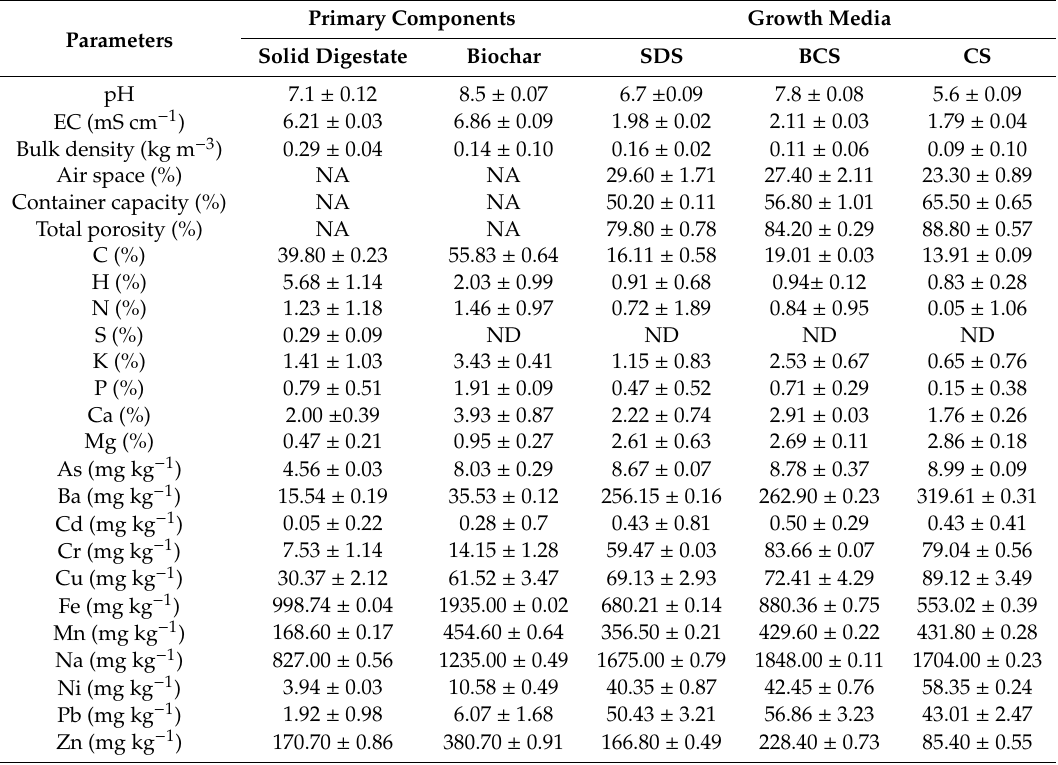
Table 1. Physical–chemical properties of organic material and growth media used in P. graveolens cultivation. All values are means of three replicates ± standard deviation. Solid digestate; biochar; SDS (Solid Digestate Substrate); BCS (Biochar Substrate); CS (Control